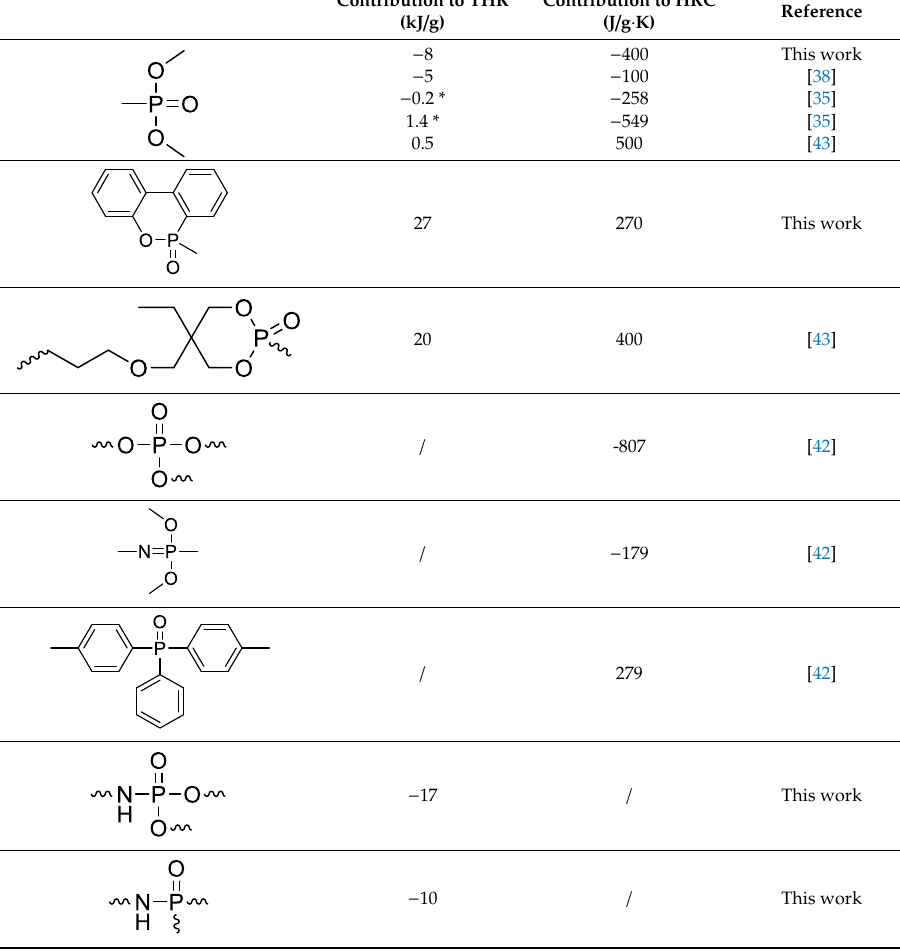
Table 3. List of phosphorus-containing groups and the corresponding contributions to flammability. Contribution to THR (kJ/g)